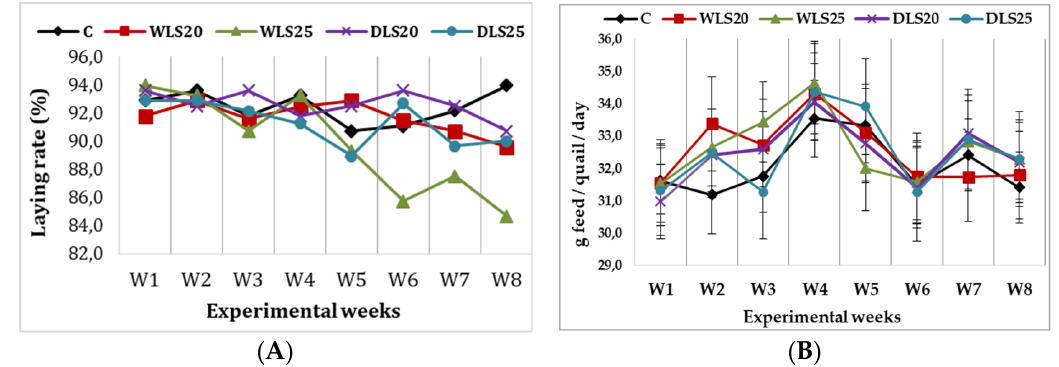
Figure 1. The influence of dehulling white lupine seeds on the laying rate evolution (%) ( A ) and daily feed intake of quails (g/quail/day) ( B ). W1–W8, experimental weeks; C, control group, without lupine; WLS 20 , experimental diet with 200 g/kg whole lupine seeds; WLS 25 , experimental diet with 250 g/kg whole lupine seeds; DLS 20 , experimental diet with 200 g/kg dehulled lupine seeds; DLS 25 , experimental diet with 250 g/kg dehulled lupine seeds.